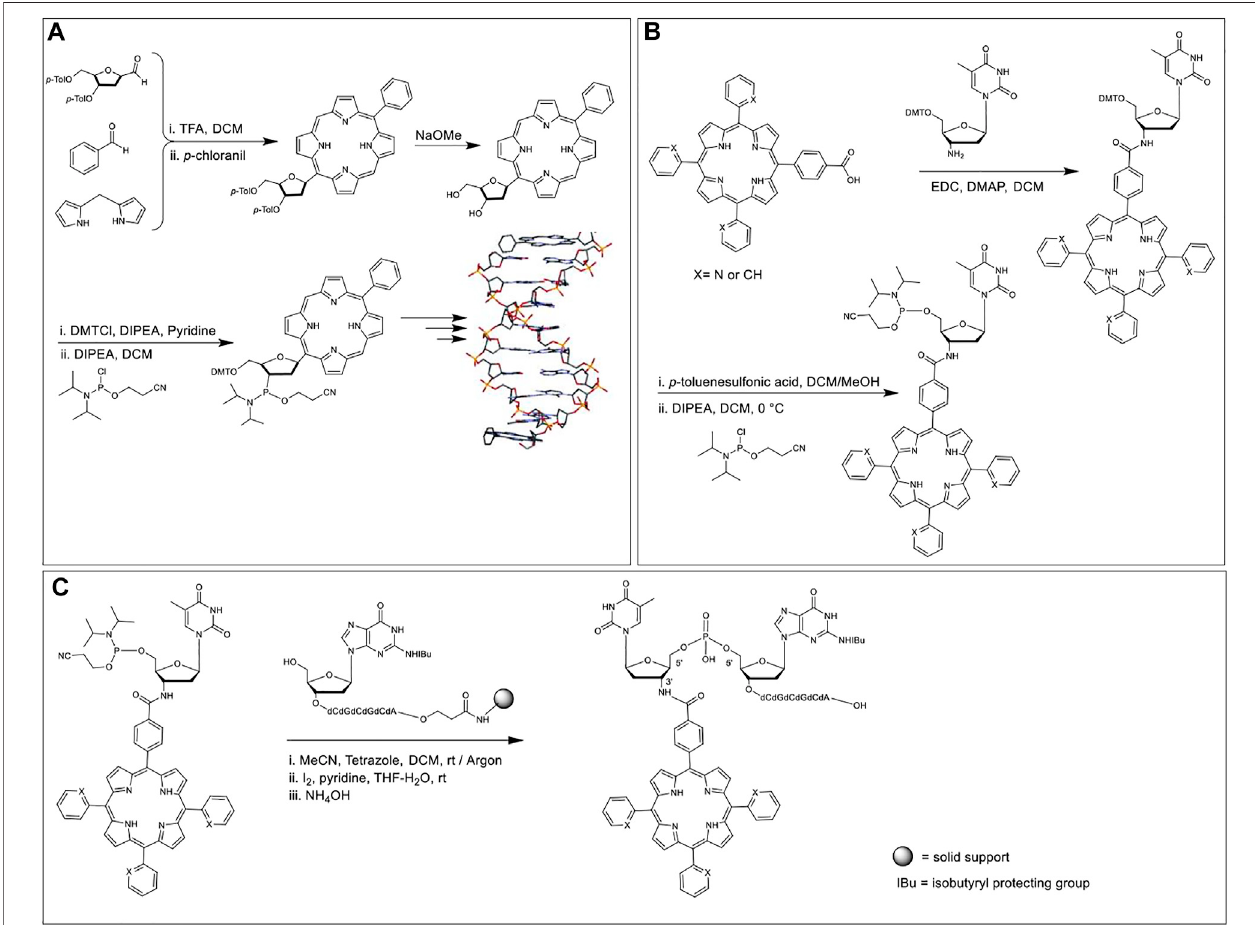
FIGURE1|(A) Porphyrinphosphoramiditeasanucleobasereplacementsynthesizedinamultistepreactionscheme.Hybridizationofself-complementary strands containing porphyrin units affords a DNA duplex where the porphyrin chromophores interact with the terminal nucleobases. Adapted with permission from (Morales- Rojas and Kool, 2002). (B) Amide coupling between 3 ′ -amino deoxyribose thymidine nucleoside and porphyrin monocarboxylic acid, subsequent DMT deprotection, and phosphitylation affords the requisite 3 ′ -porphyrin phosphoramidite. (C) An atypical 5 ′ to 5 ′ coupling using 3 ′ -porphyrin-5 ′ -phosphoramidite, followed by oxidation and deprotection (Balaz et al.,